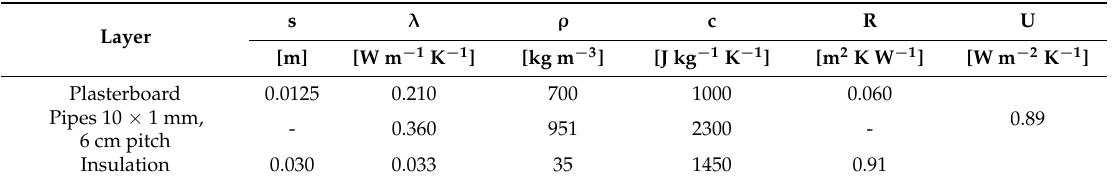
Table A7. Stratigraphy and thermal properties of the radiant ceiling with plasterboard coupled to insulation panels